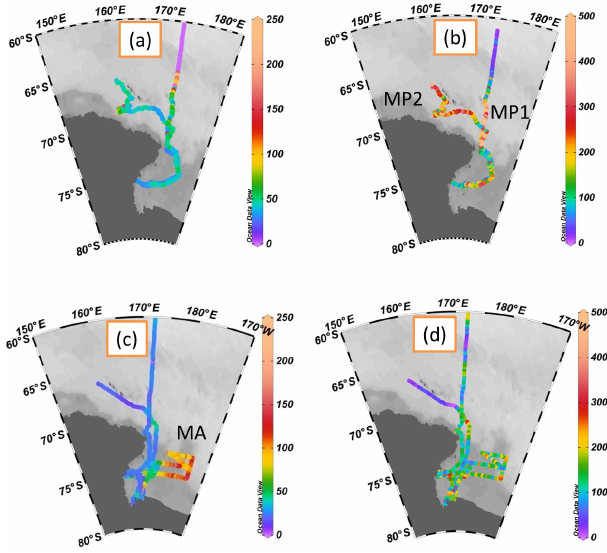
Figure 1. Spatial distributions of MSA mass concentrations and particle populations created with ODV (Schlitzer, 2002, 2015); (a) MSA mass concentrations during leg I (ngm − 3 ); (b) MSA par- ticle populations during leg I; (c) MSA mass concentrations during leg II (ngm − 3 ), and (d) MSA particle populations during leg